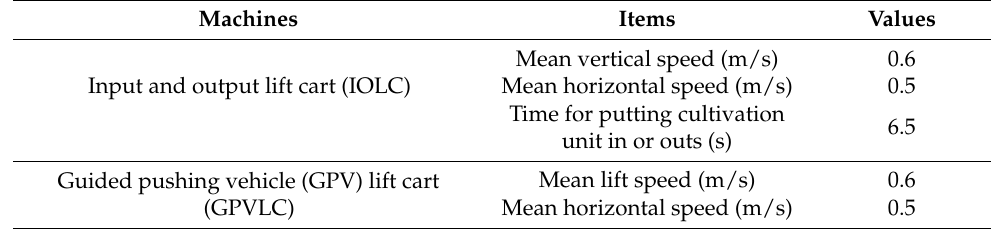
Table 1. Operation parameters of key operation links for delivering cultivation units.